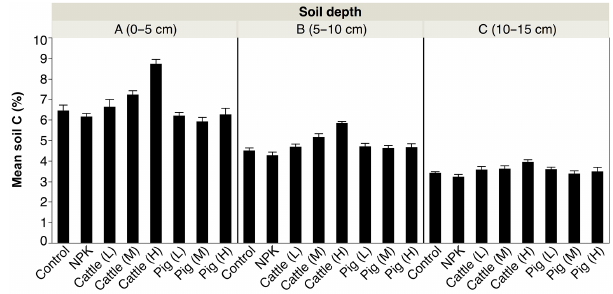
Figure 3. Relationship between mean soil C (%) content at three soil depths (A = 0–5cm, B = 5–10cm, C = 10–15cm) and differ- ent nutrient treatments as averaged for two recent years (2012 and 2013). Abbreviations as in Fig. 1. Standard errors indicate variation among six replicate values for each treatment.